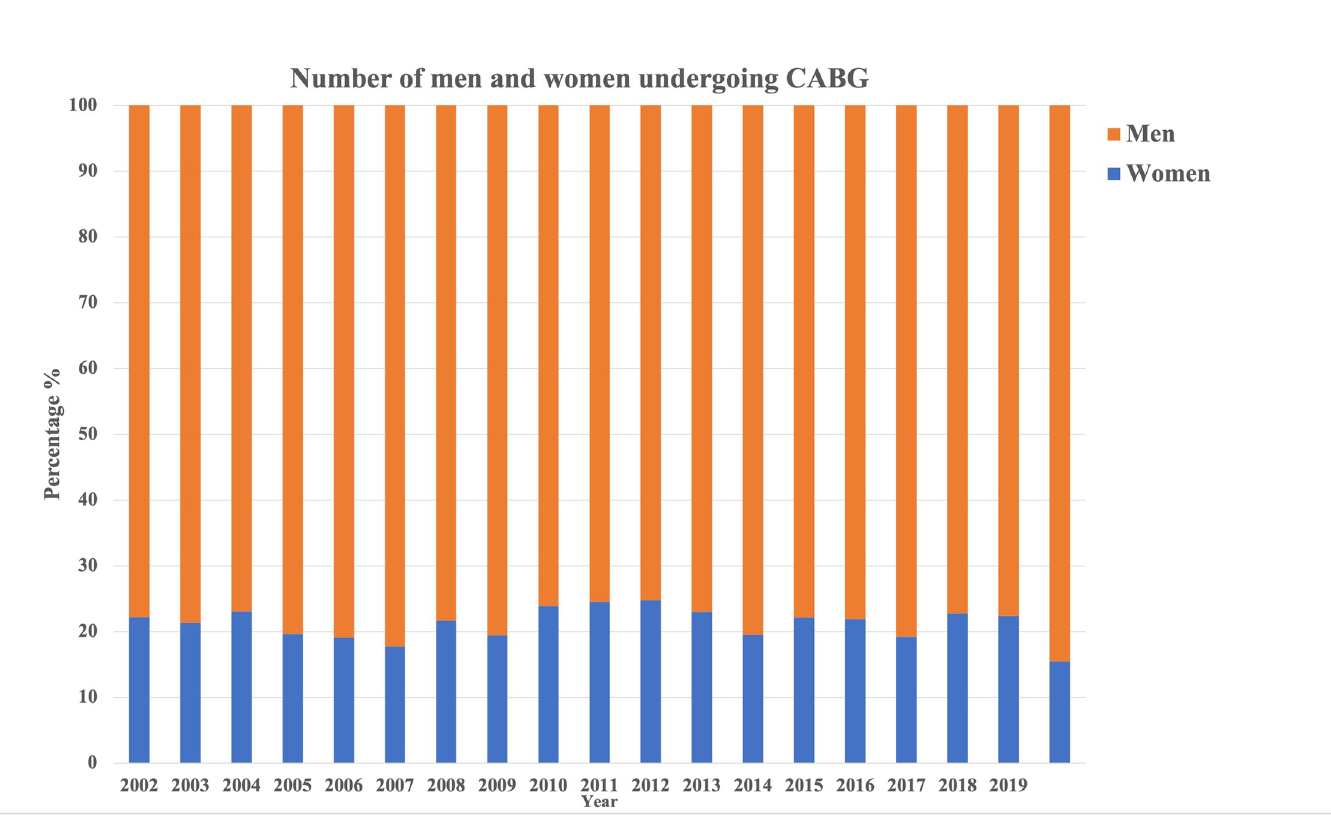
Fig 1. Number of men and women undergoing CABG surgery